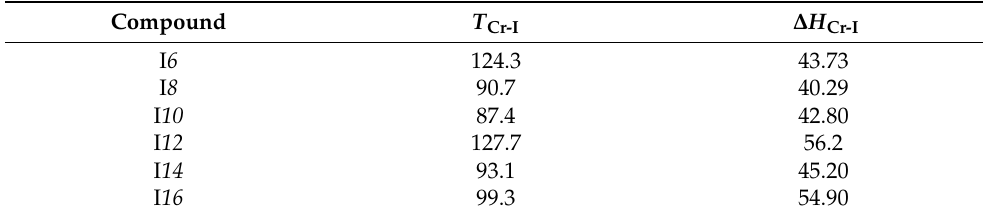
Table 1. DSC transition temperatures ( ◦ C) and enthalpy of transition ∆ H , kJ/mole for series I n .